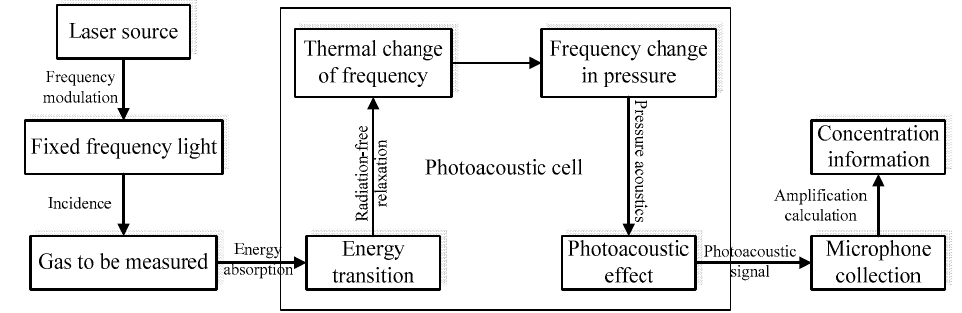
Figure 2. Schematic diagram of photoacoustic spectroscopy.